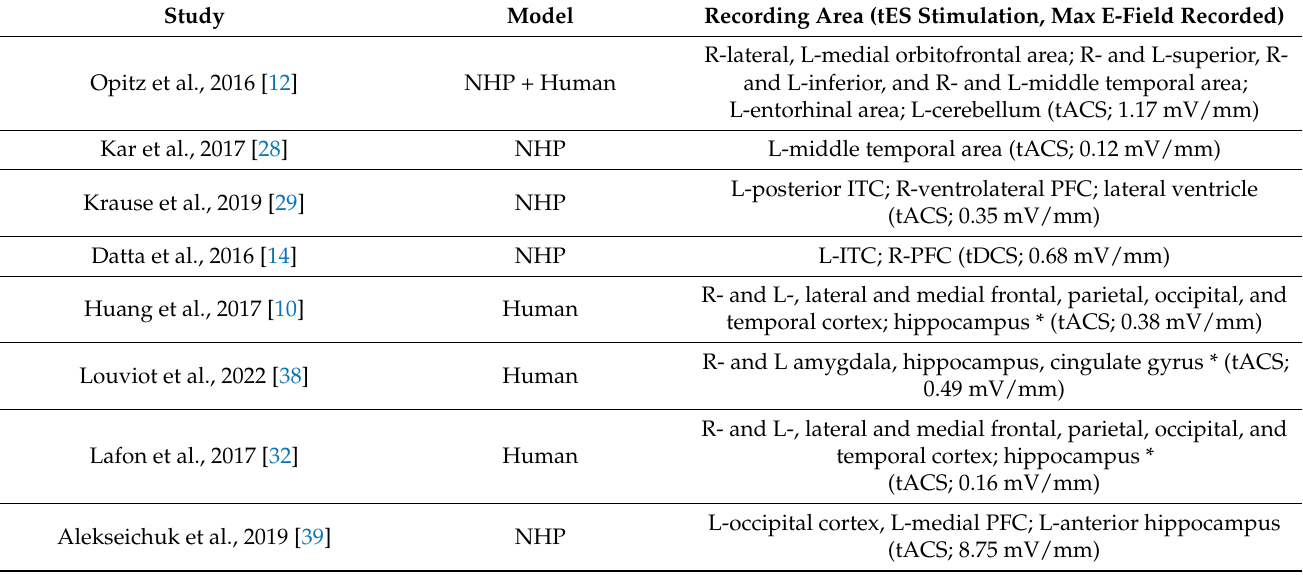
Table 3. Studies investigating electric fields in left hemisphere